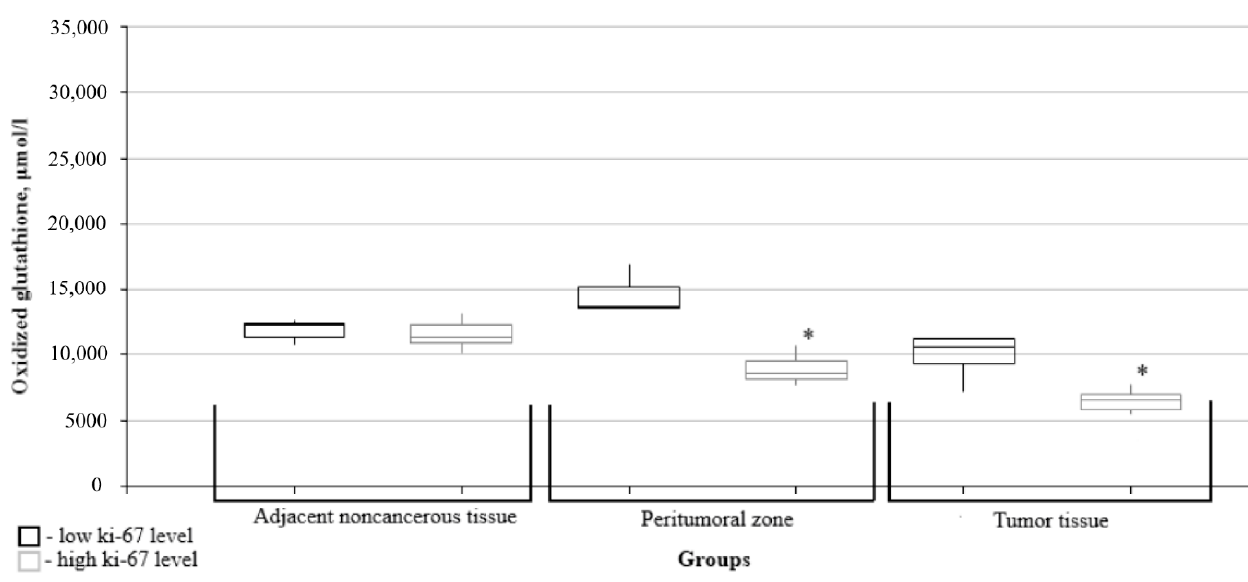
Figure 3. Medians and interquartile ranges (IQRs) of oxidized glutathione levels in gliomas as a function of the Ki-67 mitotic index value. There are significant differences between the oxidized glutathione levels in the peritumoral zone tissues (* ̵ Mann-Whitney U-test p = 0.028) and the tumors (* ̵ Mann-Whitney U-test p = 0.007) for the low and high mitotic index Ki-67 groups.